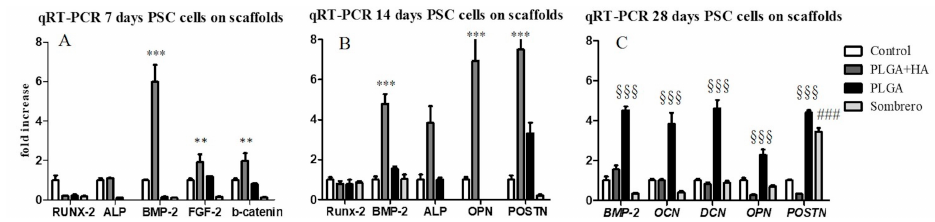
Figure 2 . Expression of the indicated bone-specific markers as determined by qRT-PCR. hPCs were seeded and cultured in contact with PLGA/HA-Alos, PLGA-Fisiograft, and PARASORB Sombrero for 7 (panel A ), 14 (panel B ), or 28 days (panel C ). The graph shows the fold induction of gene expression expressed in arbitrary units, with the expression of genes in cells grown on plastic set as